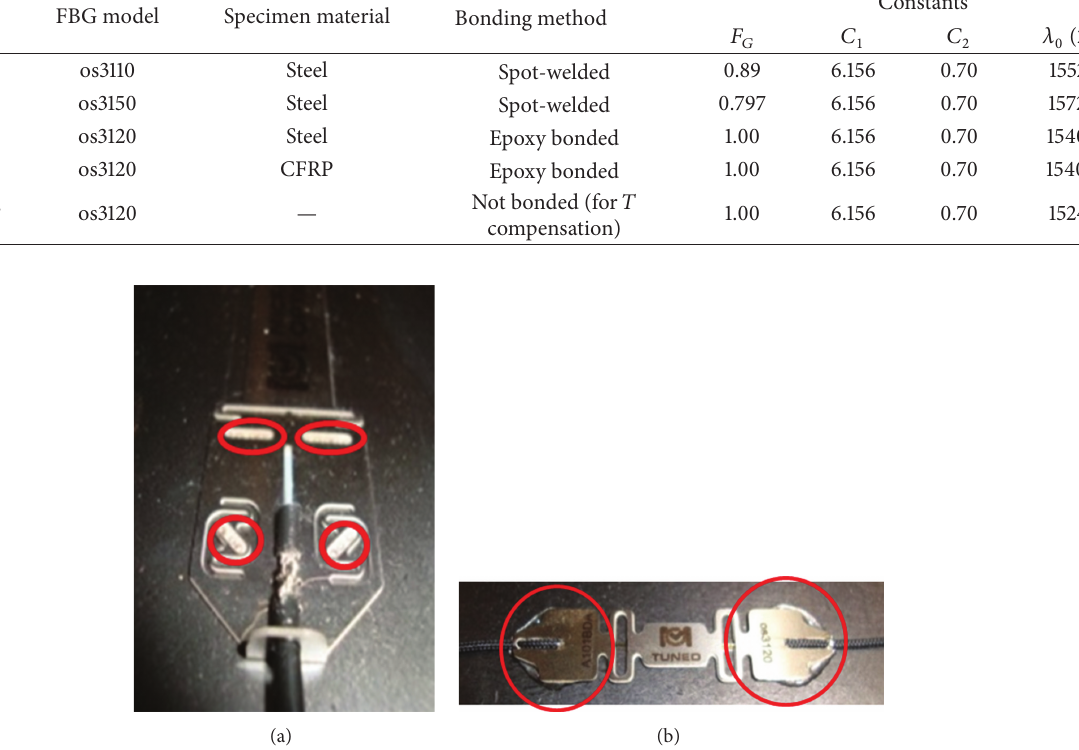
Figure 3: Instrumentation methods applied to each specimen. (a) FBG 2 is spot welded to steel specimen. (b) FBG 4 is epoxy bonded to CFRP